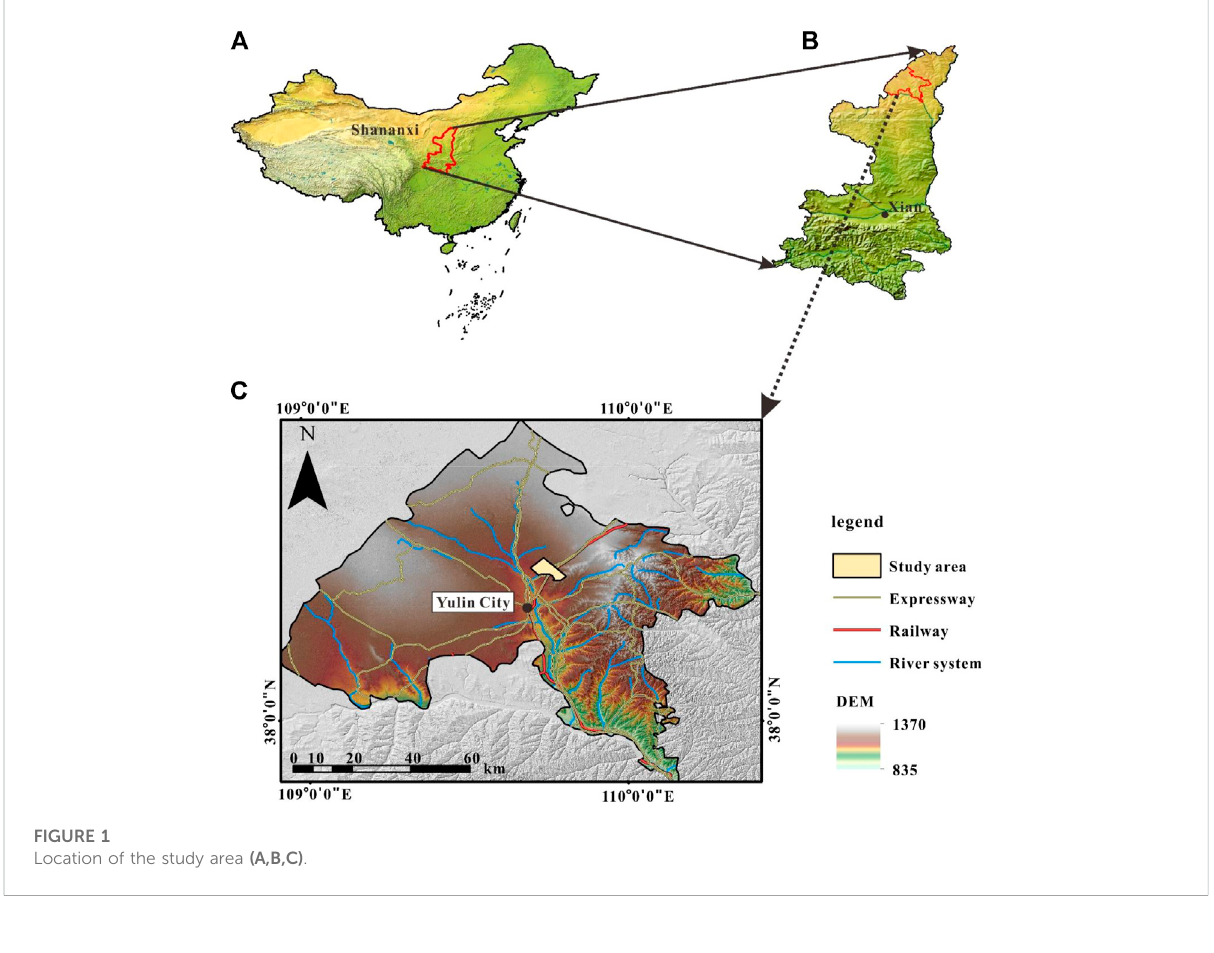
TABLE 1 Metadata about the data used in the presented